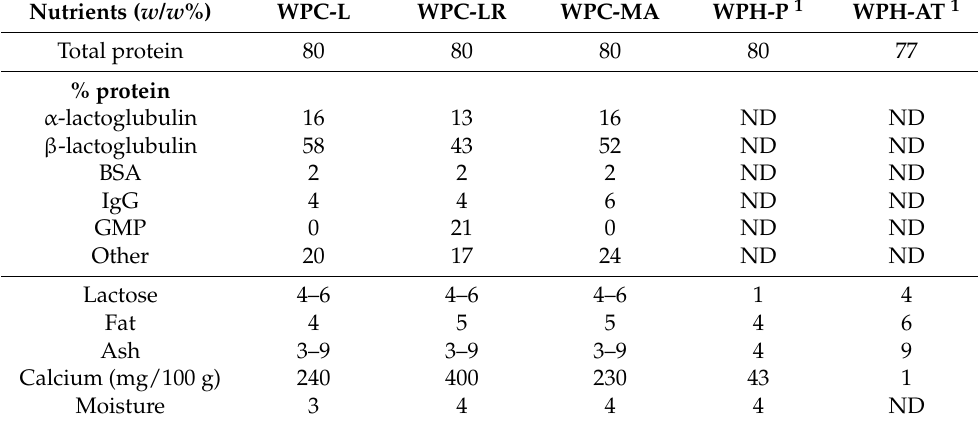
Table 1. Whey protein composition